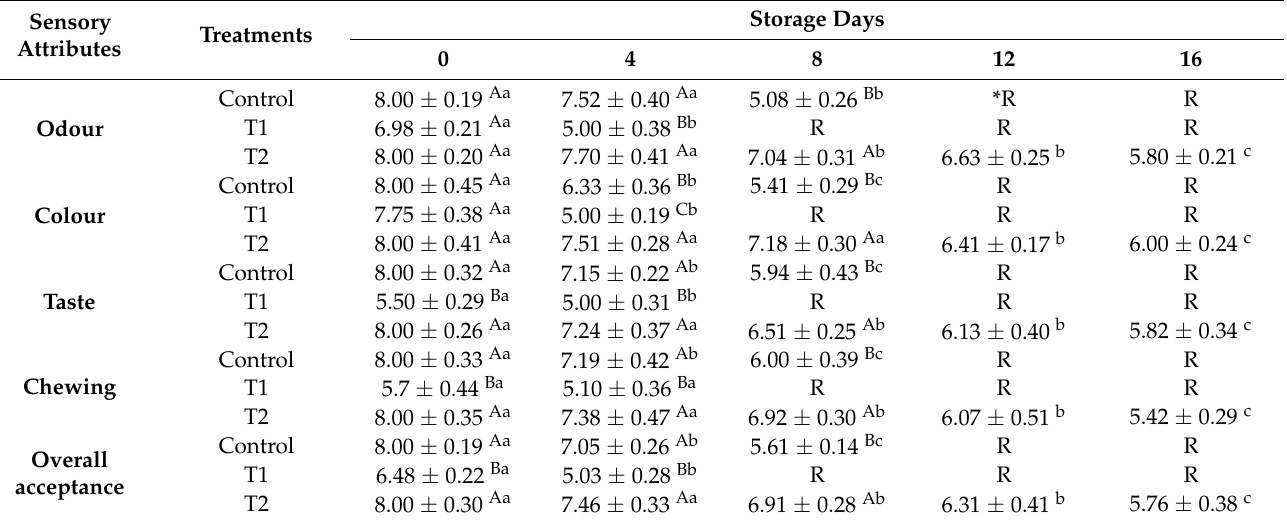
Table 3. Sensory evaluation of cooked meatballs enriched with cod liver oil microcapsules stored at 4 ± 1 ◦ C for 16